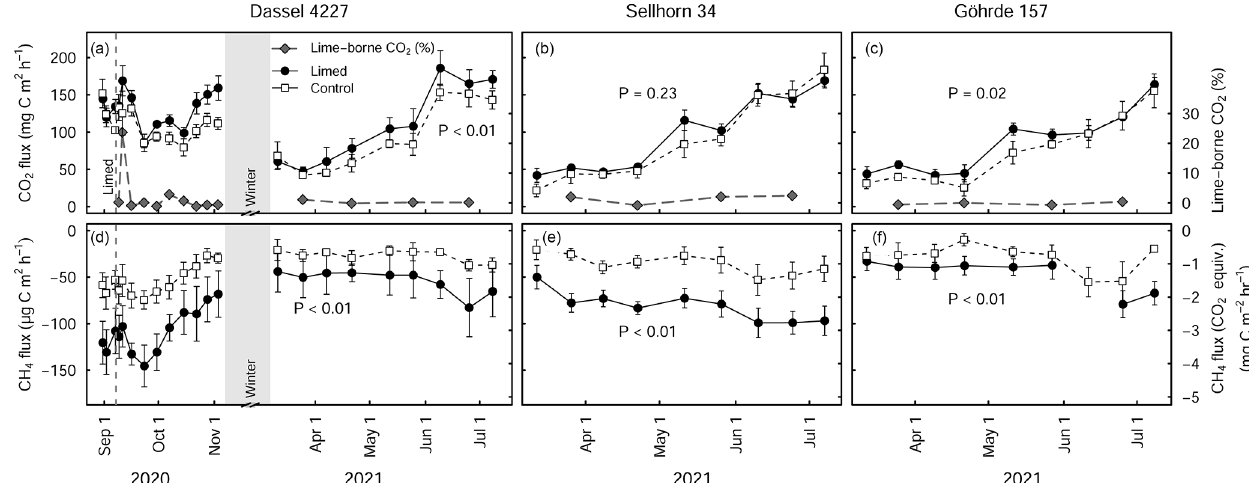
Figure 5. Mean ( ± SE) soil CO 2 (a–c) and CH 4 fluxes (d–f) at the Dassel 4227, Sellhorn 34, and Göhrde 157 sites in limed and control plots. The grey lines in (a–c) indicate the percentage of lime-derived CO 2 of the total CO 2 flux. P values indicate the significance level between treatments based on LME models. At the Dassel 4227 site, the three baseline measurements made prior to re-liming give an indication of existing long-term differences in soil CO 2 and soil CH 4 fluxes. At the time there were no significant treatment differences for CO 2 fluxes ( P = 0 . 49), but CH 4 fluxes were significant between the treatments ( P < 0 . 01). At each site, 3MgCaCO 3 ha − 1 was applied in the late summer of 2020. Soil CH 4 fluxes are presented in both actual measured units and CO 2 equivalence, based on a global warming potential of